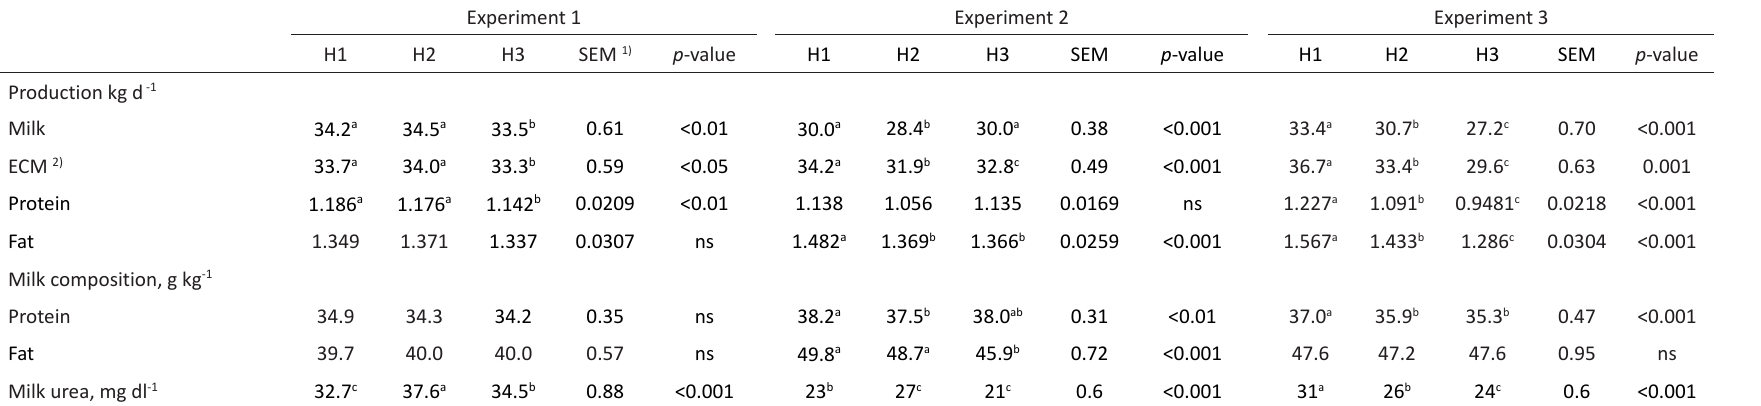
Table 5. Milk production of cows offered first (H1), second (H2) and third cut (H3) grass silages across different years.